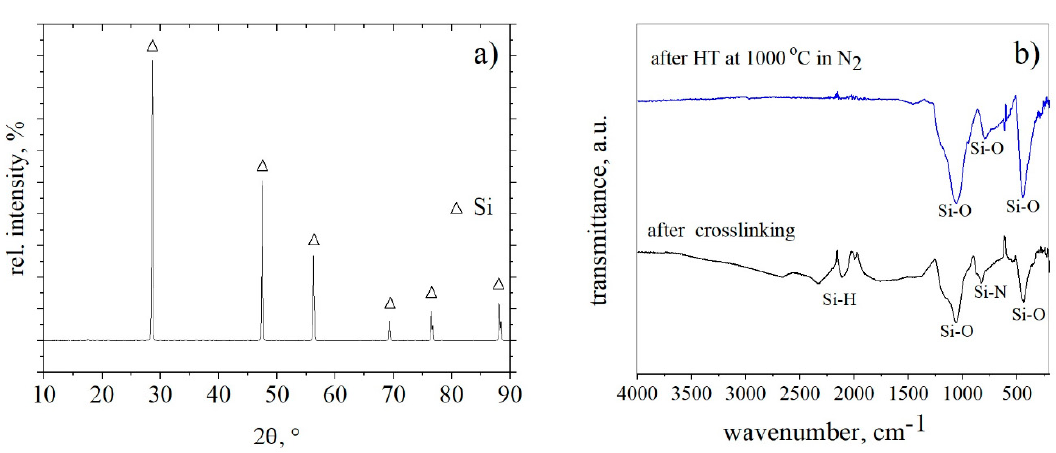
Figure 6. ( a ) X-ray diffraction patterns of the coating material after pyrolysis at 1000 °C in N 2 (heating rate and cooling rate were 3 K/min and the dwell time at max temperature was 1 h); ( b ) FT-IR (Fourier-transform infrared spectroscopy) spectra of the plain, Si- and B-filled coating system after crosslinking at 110 °C in air and after pyrolysis at 1000 °C in nitrogen.